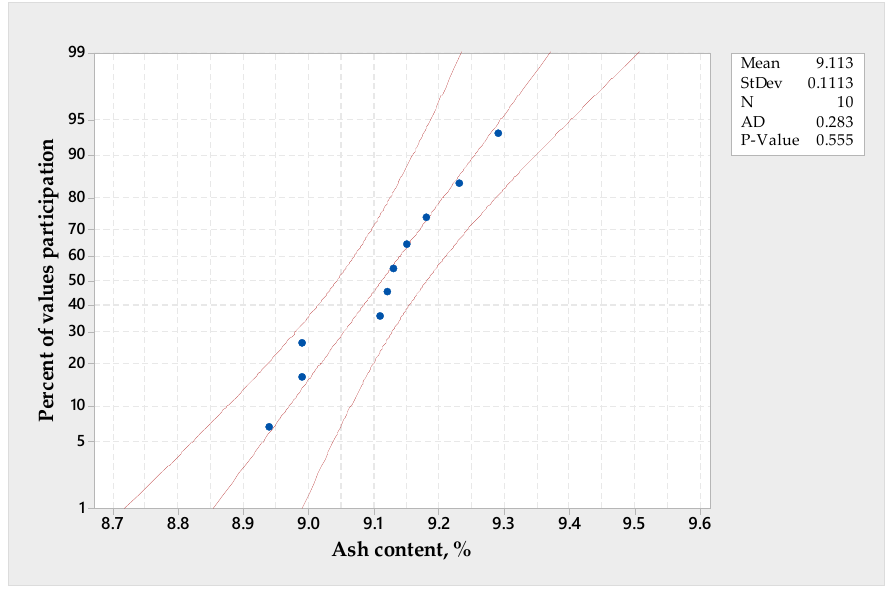
Figure 7. Probability plot of ash content for straw briquettes.